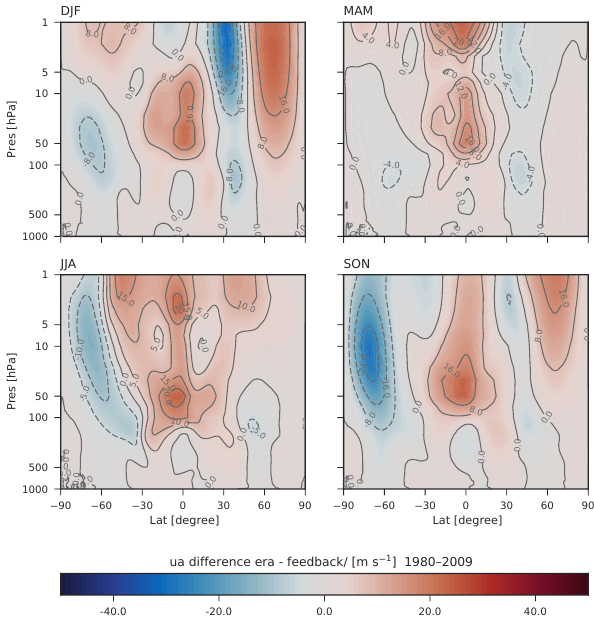
Figure B6. Latitude–height cross sections of seasonal and zonal mean zonal wind differences (ms − 1 ) for ERA-Interim minus feed- back